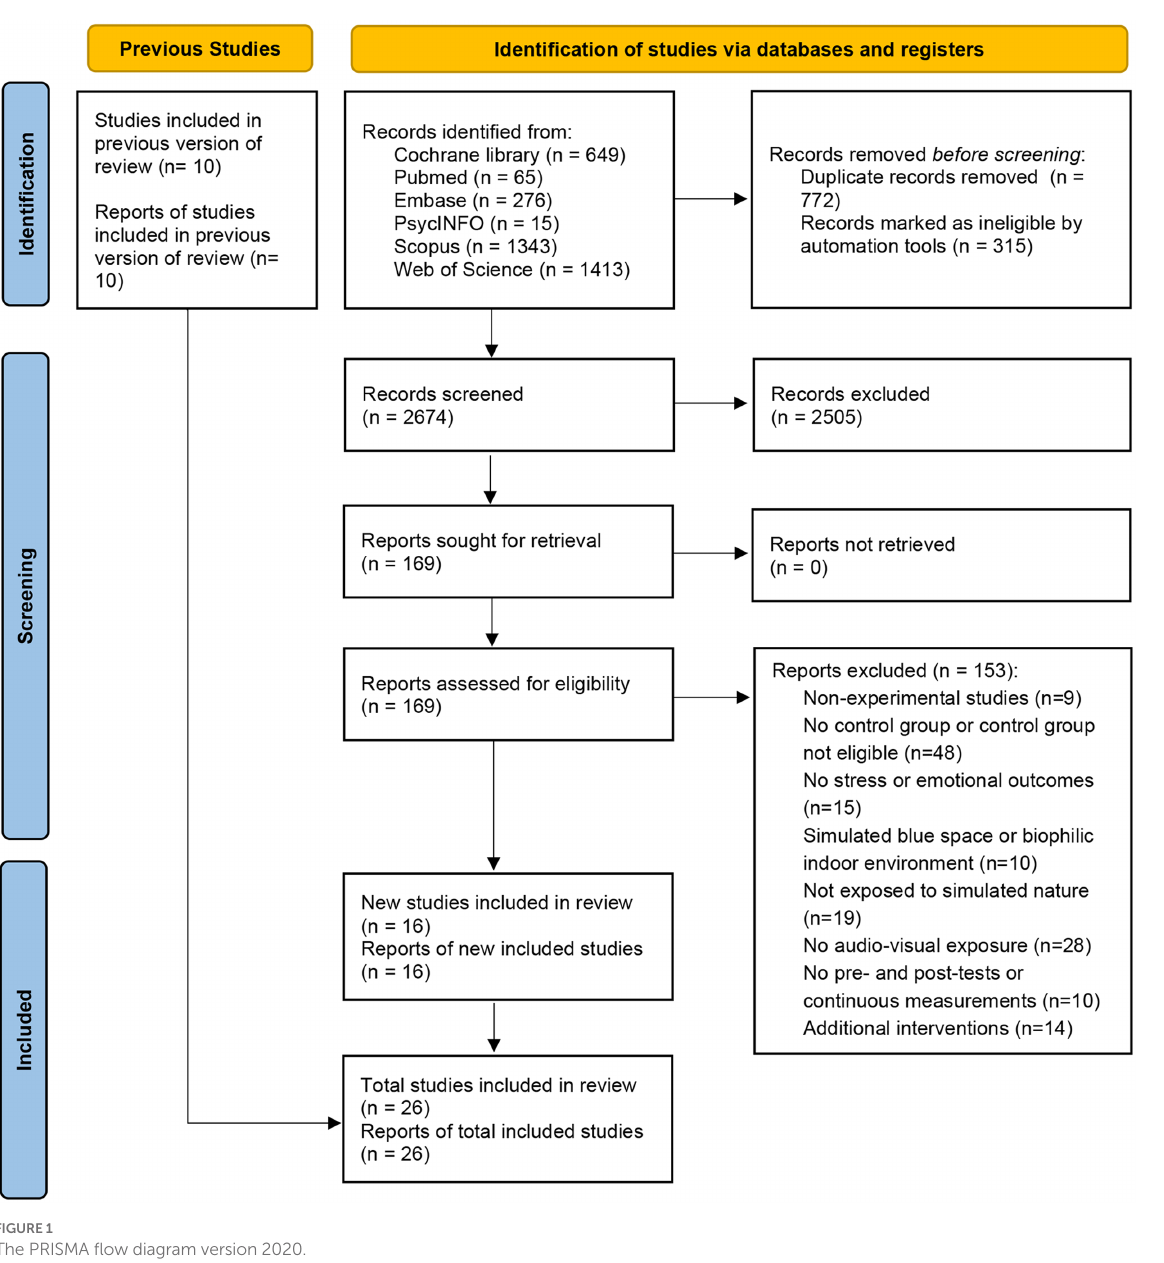
FIGURE 1 The PRISMA flow diagram version